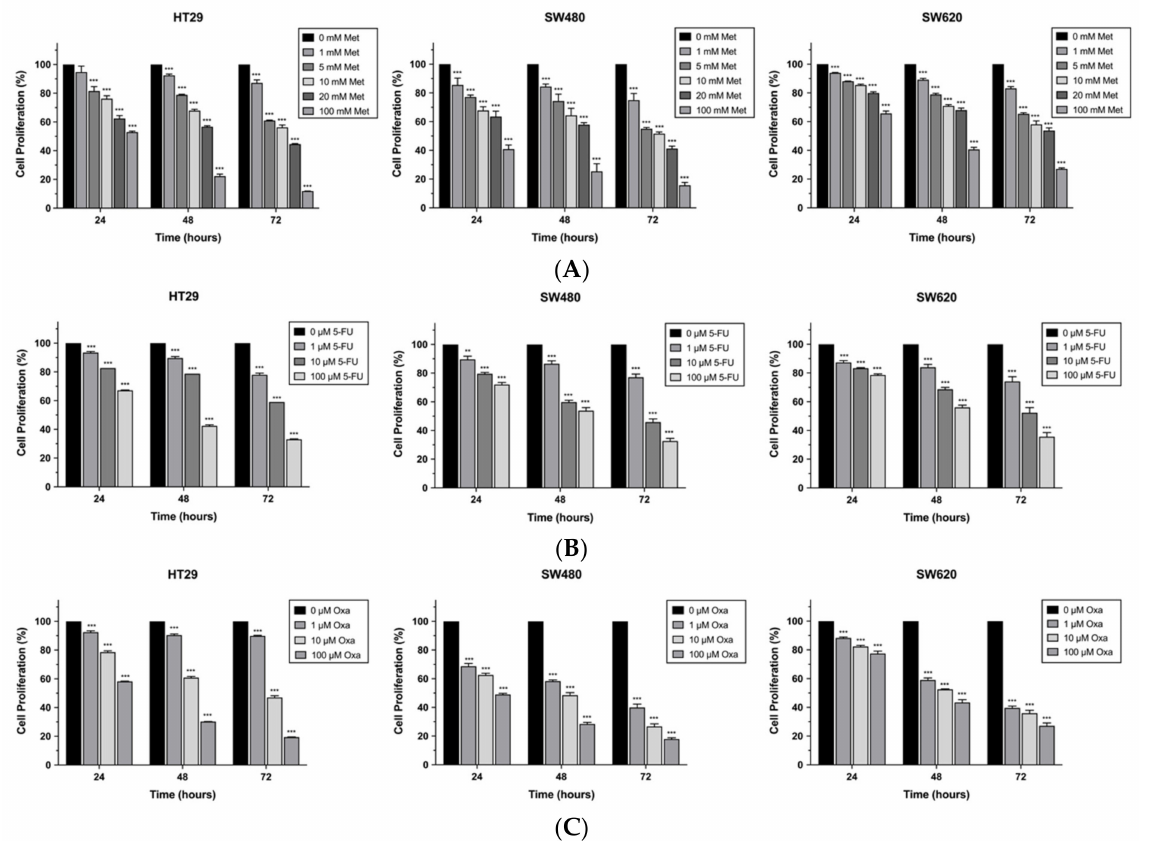
Figure 1. Metformin, 5-fluorouracil (5-FU), and oxaliplatin (Oxa) inhibit cell proliferation in CRC cell lines in dose-dependent and time-dependent manner. Cell proliferation detected at different time points after treatment with different doses and times for ( A ) metformin, ( B ) 5-FU, and ( C ) Oxa; data presented as mean ± standard error of the mean (SEM); ** p < 0.01, *** p <